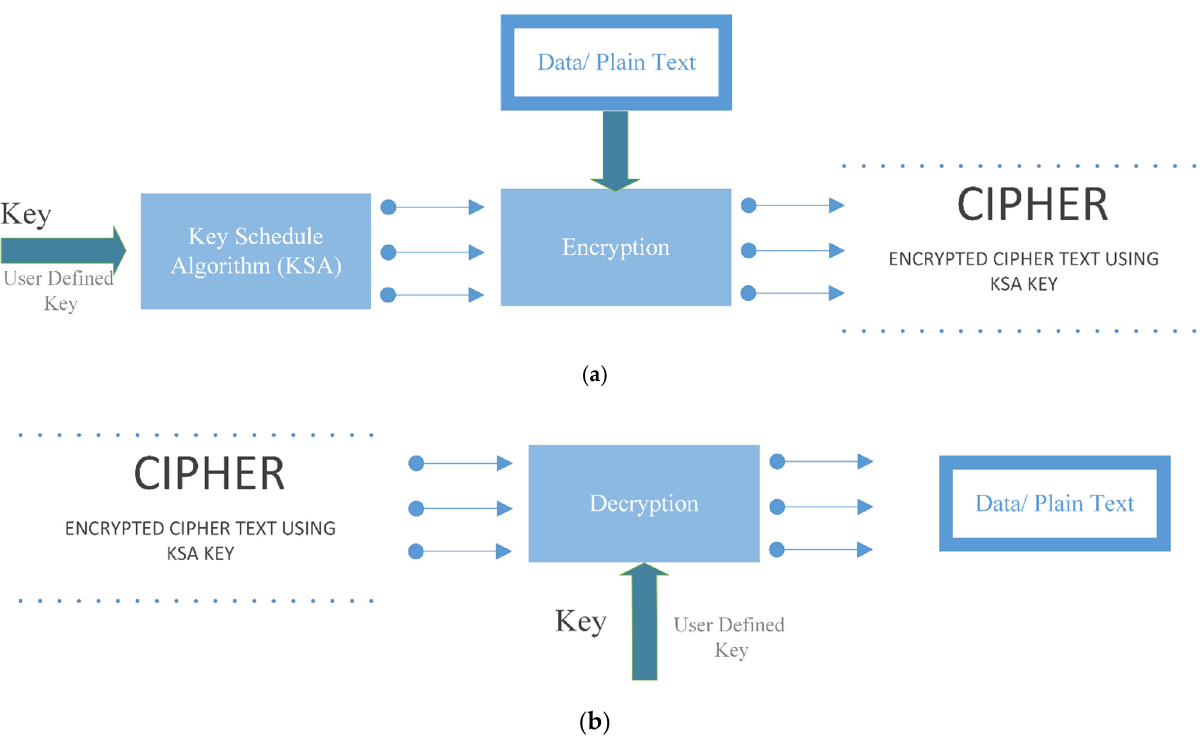
Figure 1. ( a ) Key Schedule Algorithm (KSA) and encryption of a cryptosystem; ( b ) decryption of a cryptosystem.